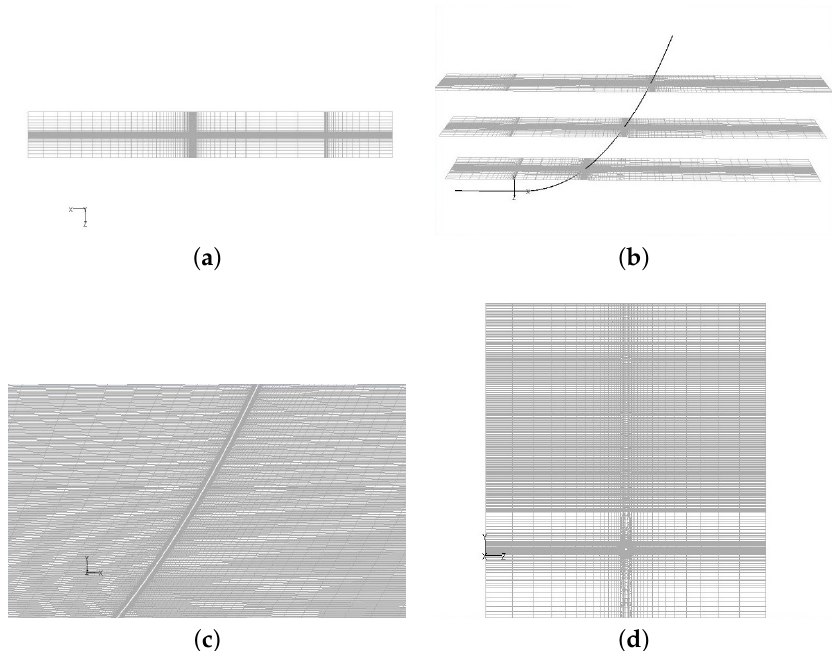
Figure 3. Schematic diagram of SCR calculation grid: ( a ) schematic diagram of the grid perpendicular to the depth direction (Y); ( b ) partial schematic diagram of different depth (Y) grids; ( c ) schematic diagram of the depth direction (Z) grid; ( d ) partial schematic diagram of the grid perpendicular to the inline flow direction